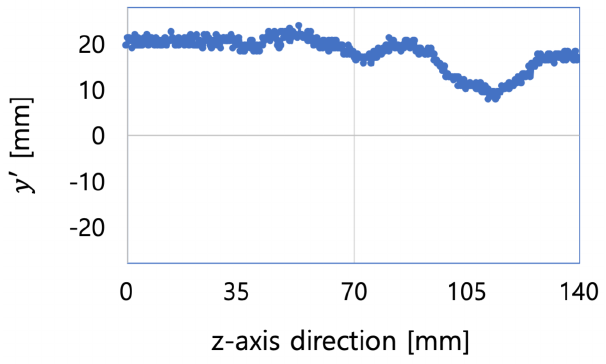
Figure 9. Measurements for arbitrary prolapse through the depth sensor, subject to the condition of the stimulator being forced from the outer parts of the